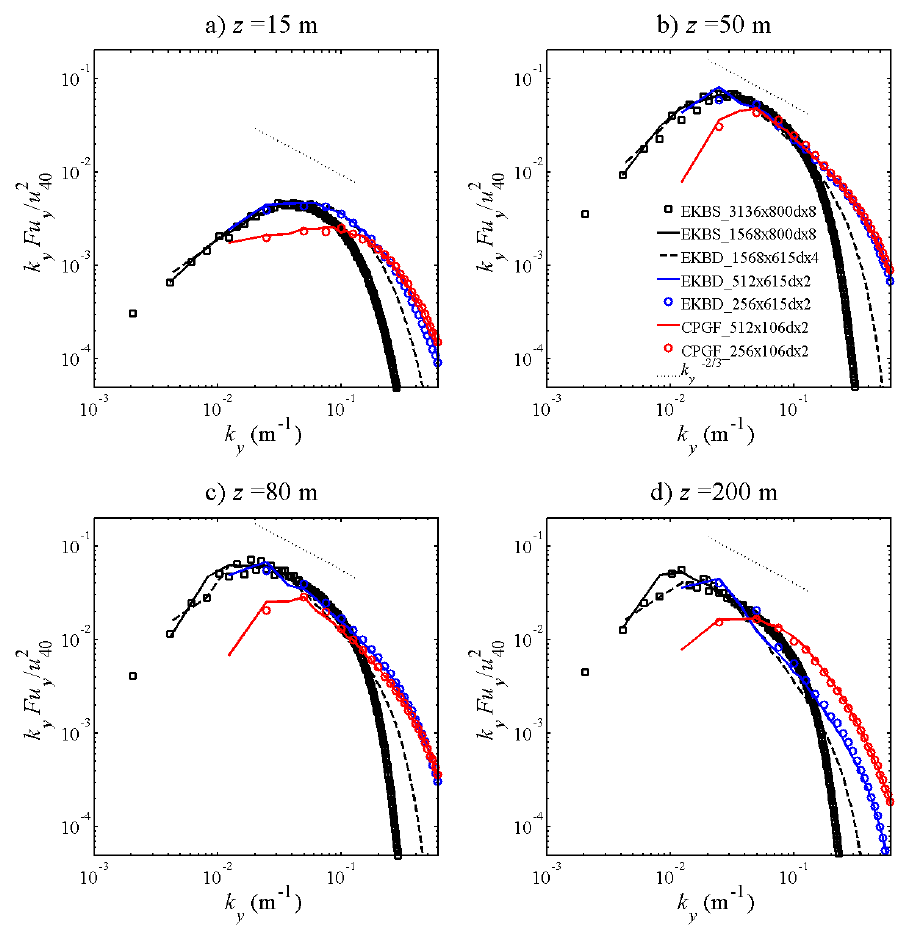
Figure 4. Spectral analysis of the u -velocity component for the sensitivity-analysis simulations, at ( a ) z = 15 m, ( b ) z = 50 m, ( c ) z = 80 m and ( d ) z = 200 m.